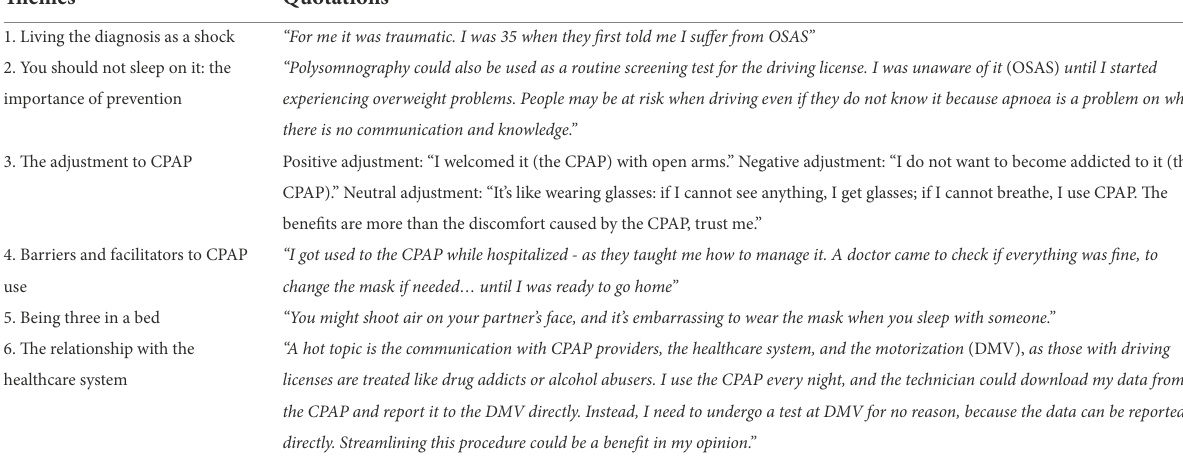
TABLE 3 Emerging themes and related illustrative